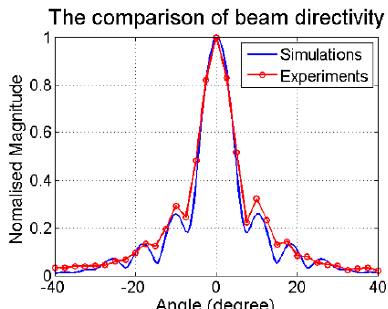
Figure 16. The scanning path of the receiver.